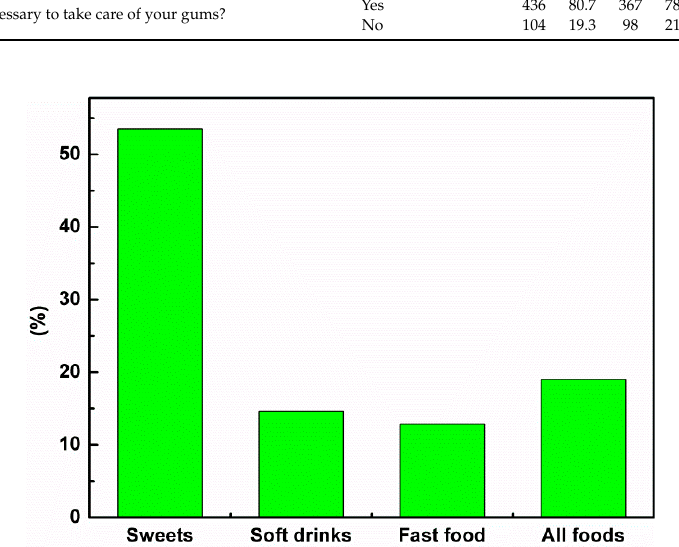
Figure 1. Source of oral health information.